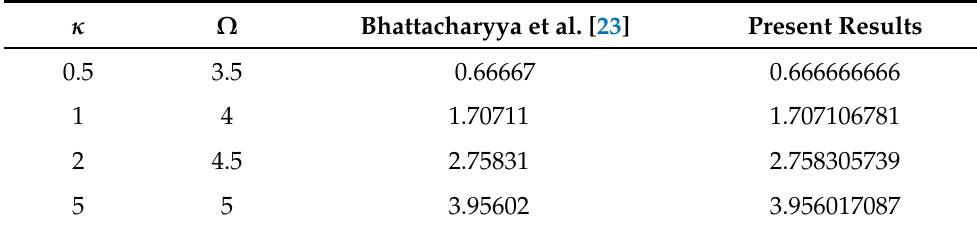
Table 4. The values of f (cid:48)(cid:48) ( 0 ) with φ = 0 and M egt = 0.